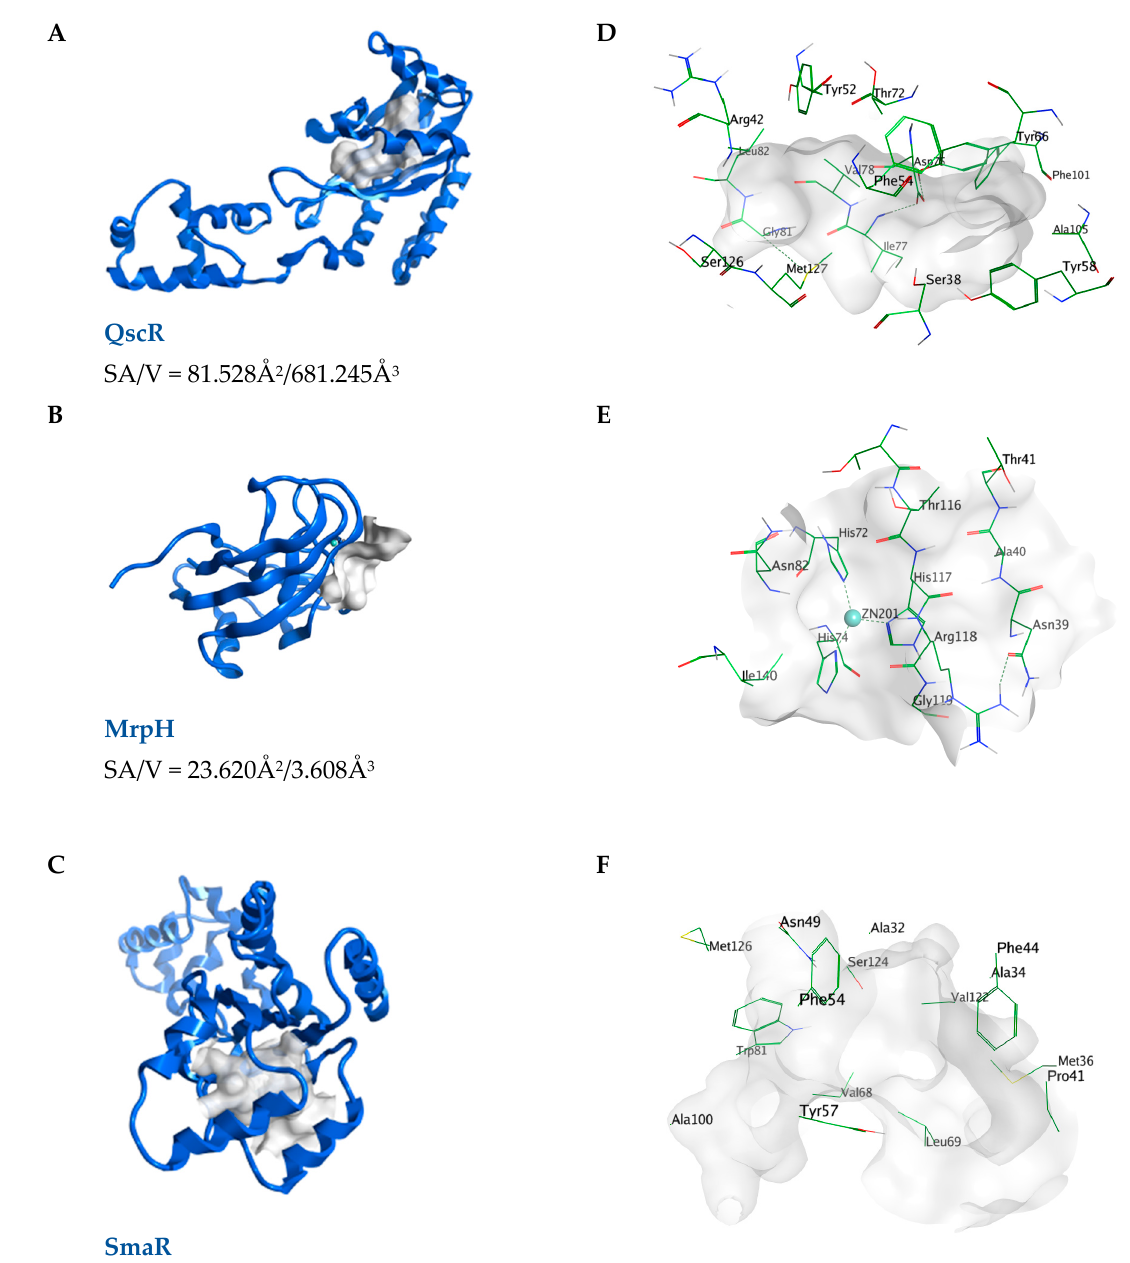
Figure 2. ( A – C ): Blue-Ribbon representation of the three bio-targets, Putative pockets; white color, SA and V were calculated via the online Computed Atlas of Surface Topography of proteins (CASTp; http://sts.bioe.uic.edu/castp/index.html (accessed on 28 May 2022)), ( D – F ): 3D view of the active site indicating the main amino acid residues lining the pocket.